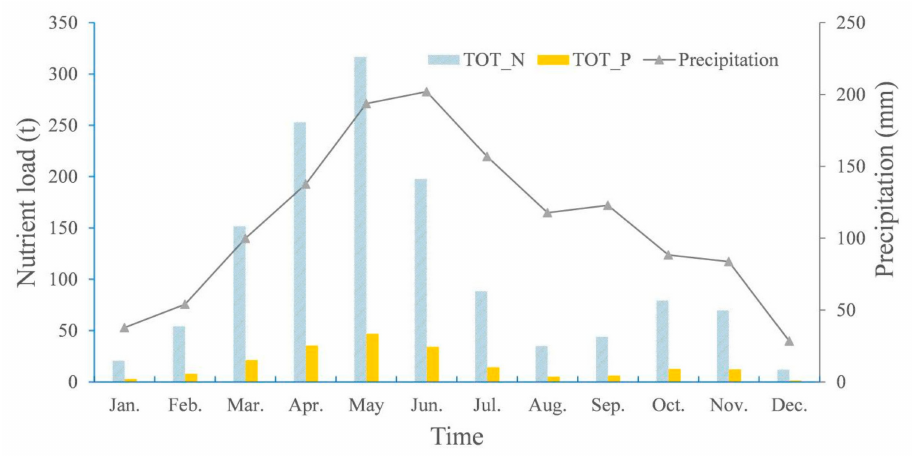
Figure 8. Average monthly nutrient load from 2011 to